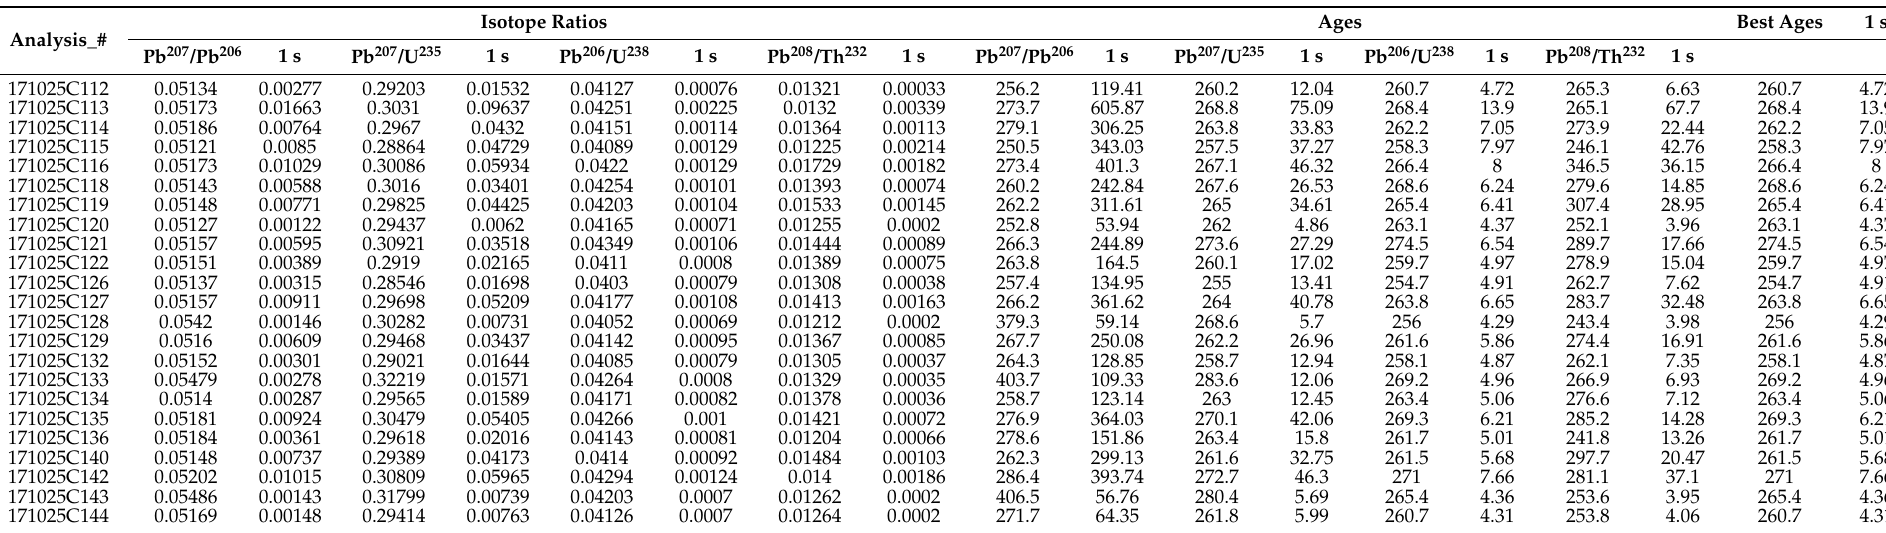
Table A1. LA-ICP-MS U-Pb isotope analytical results for zircon crystals from the hornblende gabbro of the Baogeqi gabbro